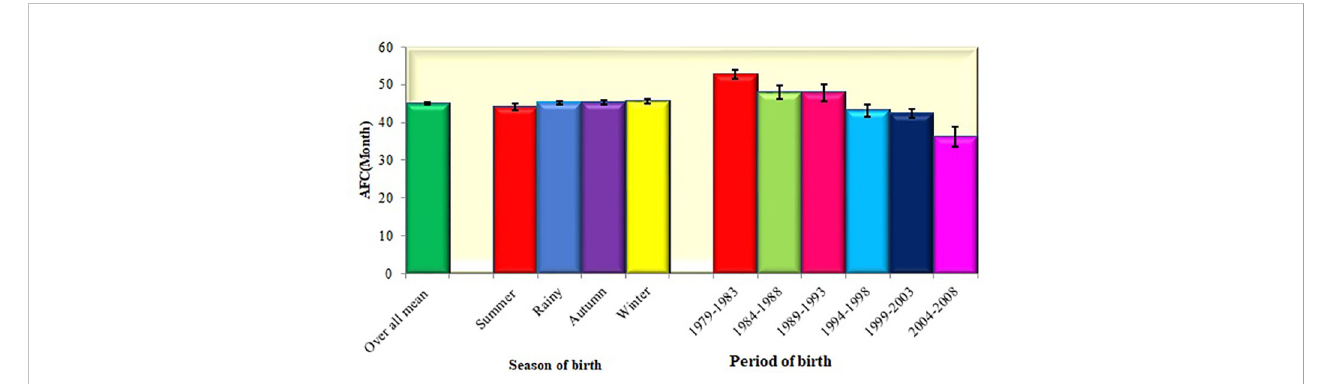
FIGURE 1 Least-squares means (LSMs) with standard errors (SEs) for age at fi rst calving (AFC) in Nili-Ravi